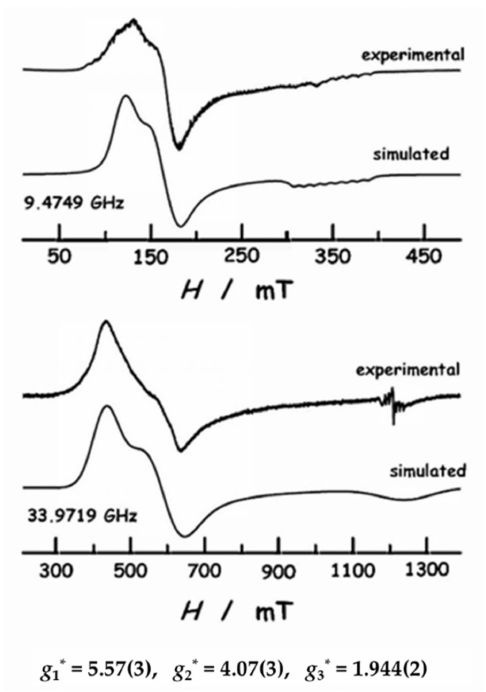
Figure 3. X-band (9.475 GHz, top) and Q-band (33.972 GHz, bottom) EPR spectra of the polycrys- talline diluted sample 2 measured at T = 6 K, plotted as a function of magnetic field. Comparison of spectra with the simulation, calculated with EasySpin using the g * parameters given in the lower part of the graph and collected in Table